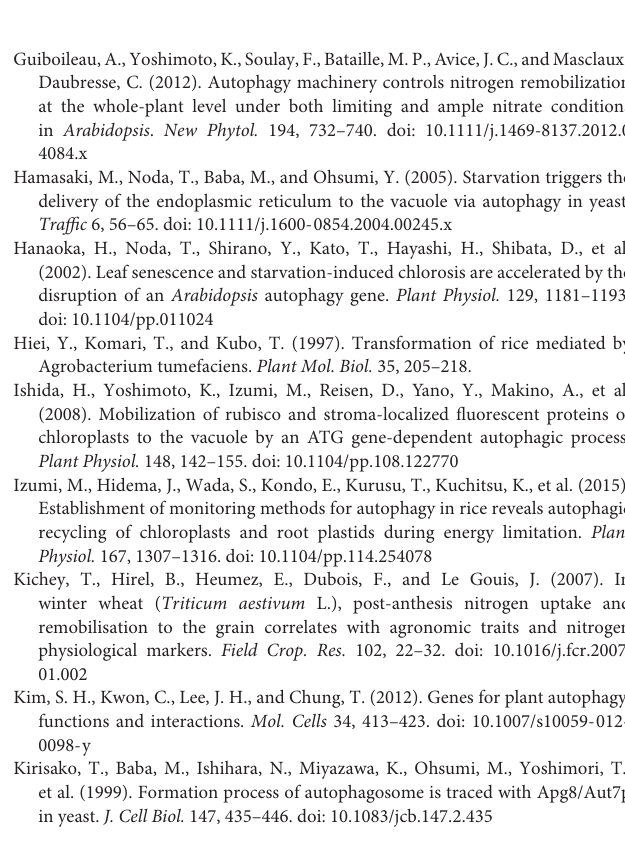
divided into the shoots and roots. OseEF-1a was used as an internal reference. Error bars indicate standard deviations of independent biological replicates ( n = 3). No asterisks mean no significant difference ( t -test). FIGURE S6 | OsATG8b -RNAi (Ri) and OsATG8b -OE (OE) lines exhibited a relatively normal phenotype and a similar growth rate when compared with ZH11 at 30 and 60-day after germination (DAG). (A,B) Phenotype of OsATG8b -RNAi and OsATG8b -OE plants grown under low (LN, 0.2 mM NH 4 NO 3 ) (A) and high N contents (HN, 5 mM NH 4 NO 3 ) (B) at 30 DAG. (C,D) Statistical analysis of root (C) and shoot (D) length of OsATG8b -RNAi and OsATG8b -OE plants grown under both LN and HN conditions at 30 DAG. (E,F) Phenotype of OsATG8b -RNAi and OsATG8b -OE plants grown under LN (E) and HN (F) conditions at 60 DAG. (G,H) Statistical analysis of root (G) and shoot (H) length of OsATG8b -RNAi and OsATG8b -OE plants grown under both LN and HN conditions, at 60 DAG. Three biological replicates, each containing thirty plants, were used for data analysis. Error bars indicate standard deviations of independent biological replicates. No asterisks mean no significant difference ( t -test). FIGURE S7 | 15 N-labeling efficiency of ZH11, OsATG8b -RNAi (Ri), and OsATG8b -OE (OE) lines. Plants at 40-day after germination were labeled for 5-day with 15 NO 3 − , harvested 7-day later, and then assayed for 15 N content in seedlings. Results are the mean ± SD from three plants. Three biological replicates, each containing three plants, were used for data analysis. FIGURE S8 | Spatio-temporal expression of OsATG8a (A) , OsATG8b (B) , and OsATG8c (C) in various tissues/organs throughout the entire plant growth in the field. Data were obtained from RiceXpro (http://ricexpro.dna.affrc.go.jp/). FIGURE S9 | OsATG8b antibody cannot distinguish OsATG8a, OsATG8b, and OsATG8c. The proteins of OsATG8a, OsATG8b, and OsATG8c were expressed in E. coli , and detected by the anti-OsATG8b antibody. TABLE S1 | All primers used in this